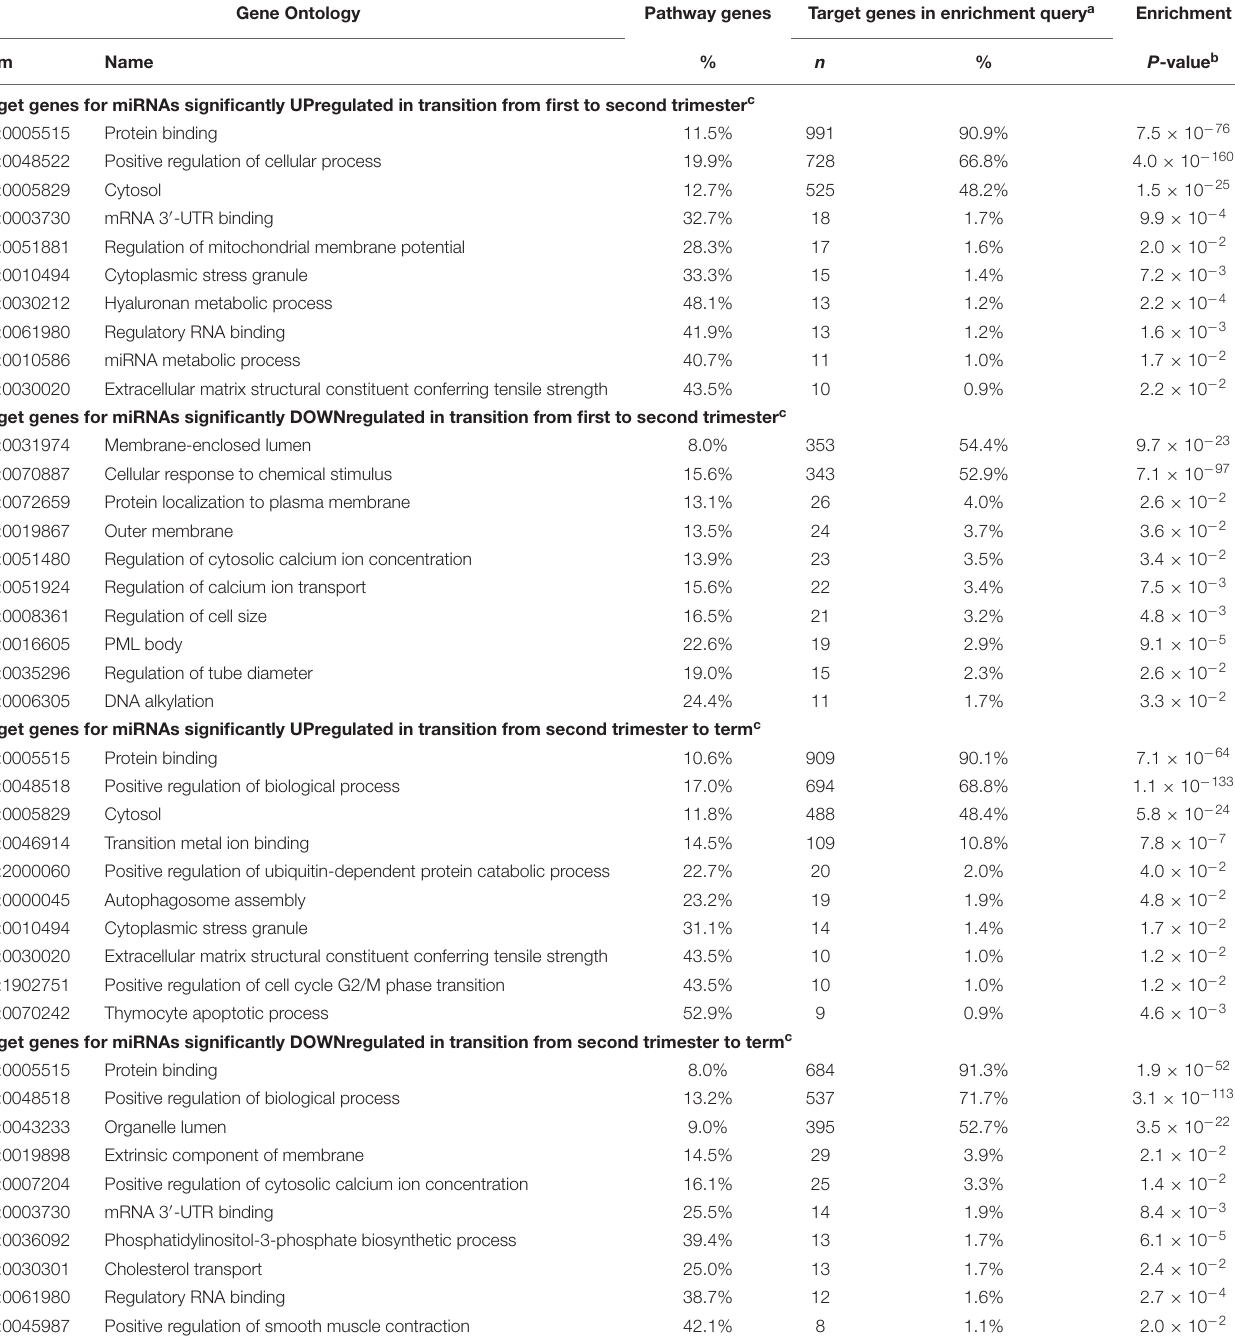
a Top 10 pathways per each gene list analysis are shown, sorted by the highest percentage of representation among the query genes. Full results of in silico functional enrichment analyses of gene lists are in Supplementary Tables 12 , 13 . b P-value corrected for multiple testing by g: SCS method (Reimand et al., 2007). c Query lists of miRNA target gene were extracted from the miRTarBase database (Huang et al., 2020).